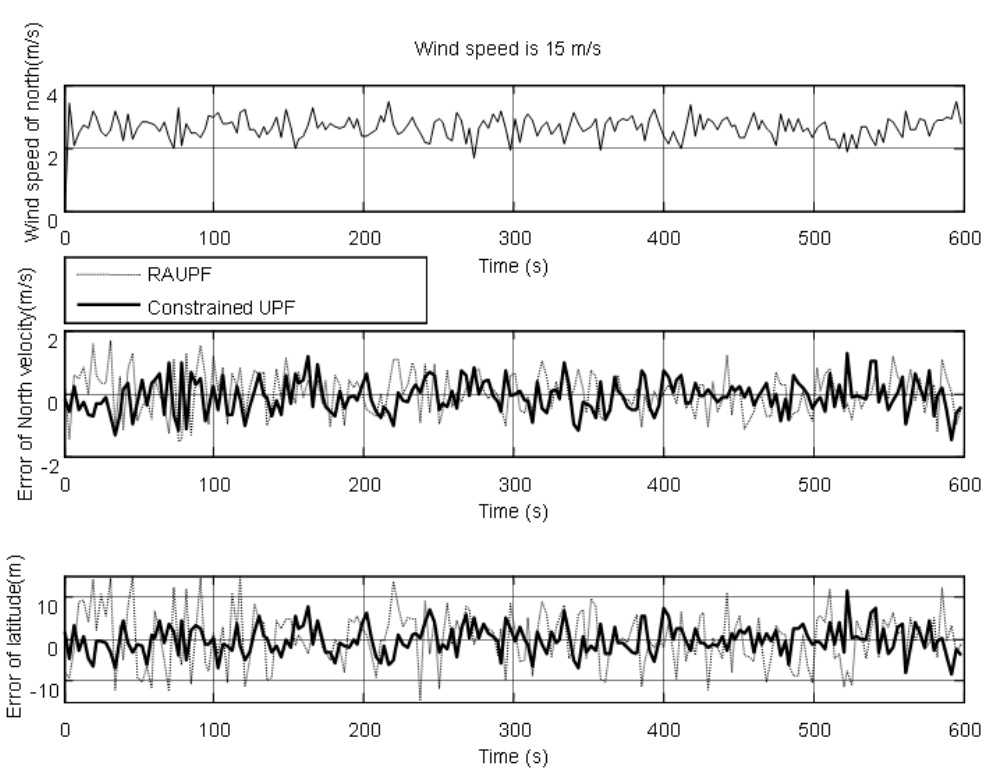
Figure 6. North velocity and latitude errors under the wind speed of 15 m/s.